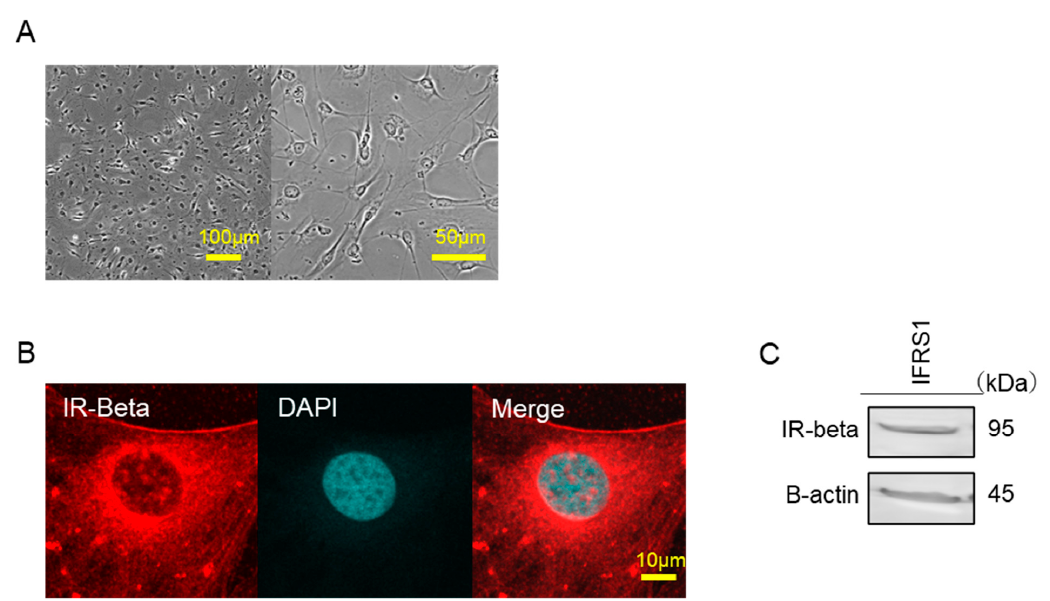
Figure 1. ( A ) Differential interference contrast (DIC) microscopic image of IFRS1. ( B ) Confocal immunofluorescence analysis of IFRS1 treated with anti-IR-beta rabbit mAb labeled with Alexa Fluor 568-conjugated phalloidin (red). Blue pseudo color-DAPI. ( C ) IR-beta was identified by Western blot analyses using the anti-IR-beta antibody.